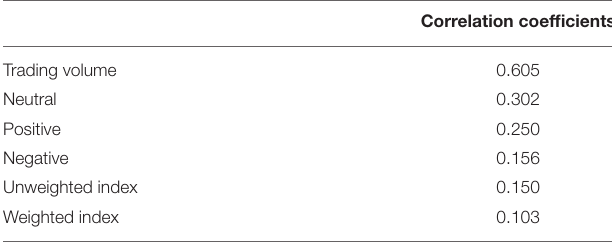
TABLE 3 | 5-factor correlation coefficients between the chosen feature and the price data,